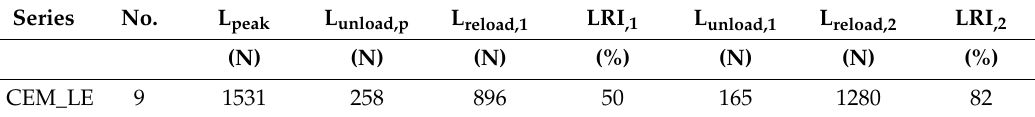
Table 5. Overview of the parameters characterizing the static flexural behaviour of the CEM_LE_9. Series